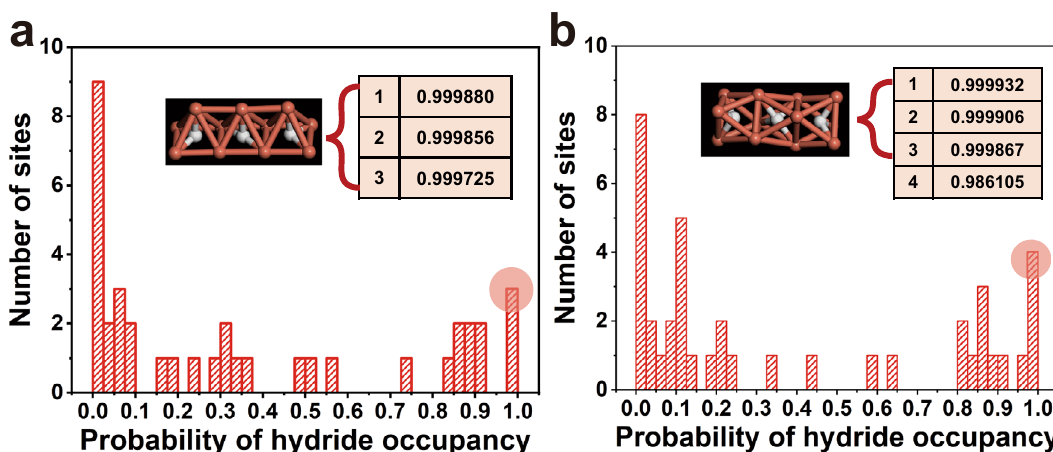
Fig. 4 Neural network prediction of hydride sites. Probability distribution of hydride occupancy in the possible sites as predicted by convolutional neural network: a Cu 11 H 3 ; b Cu 12 H 3 . Insets show the probabilities of the top-ranked sites and their positions in the clusters before DFT optimization. Color legend: Cu, dark salmon; Hydride, white.